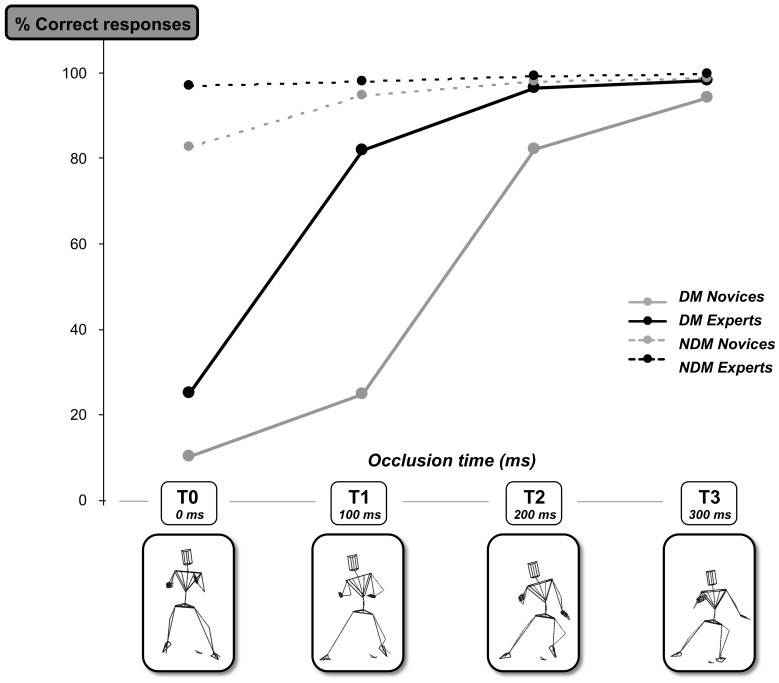
Overview of correct responses for both Novice and Expert participants.Mean percentage of correct responses for both novice (grey line) and expert (back line) groups when presented with deceptive (DM – solid line) and non-deceptive (NDM – dashed line) movements at the four different occlusion times (T0, T1, T2 and T3). The stick figures below represent the differences in static body configuration at each occlusion time.